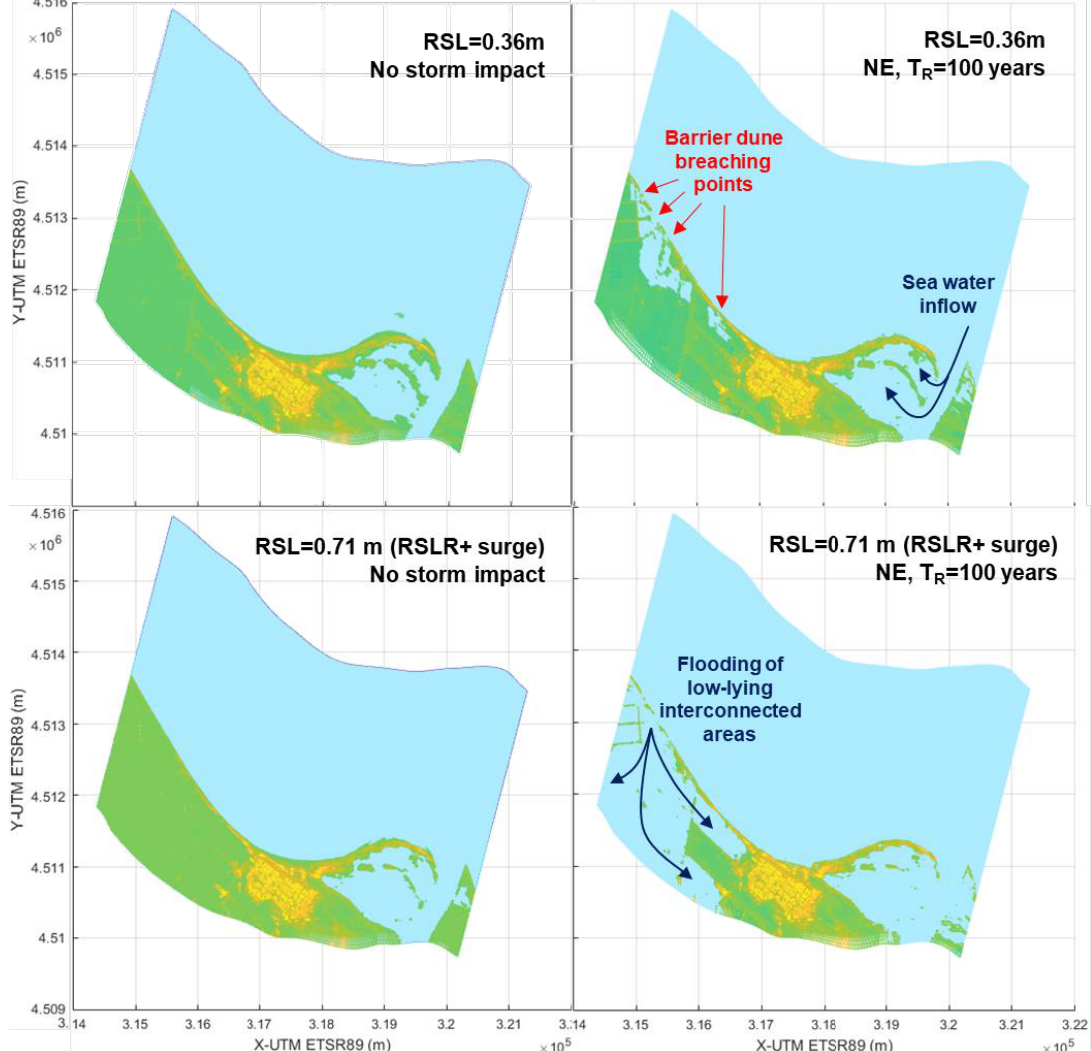
Figure 7. Flood map before (left) and after (right) the impact of a northeastern storm of 100-year return period. Left panels can be considered as the effect of static sea level (i.e., bath-tub approach). Top pictures correspond to scenario 3 (future climate, 2050 sea level rise (SLR), no storm surge), while bottom pictures are associated to scenario 4 (future climate, 2050 SLR, storm surge). Green areas represent emerged elevation below 1 m; whereas yellow areas are above 1 m.